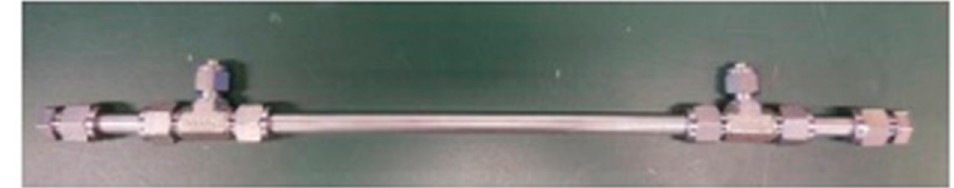
Figure 2. Hollow Fiber Membrane Module.